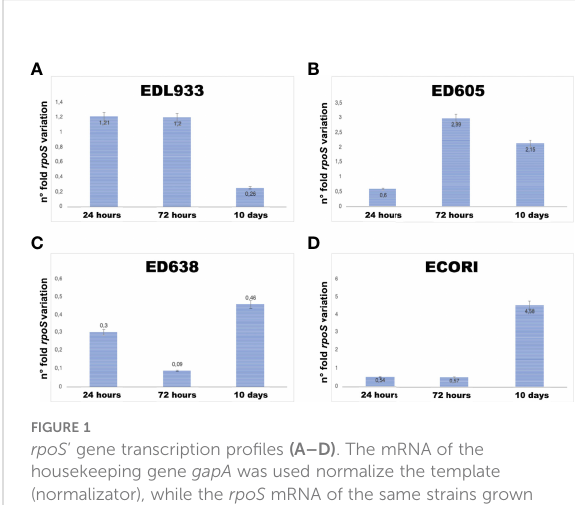
FIGURE 1 rpoS ’ gene transcription pro fi les (A – D) . The mRNA of the housekeeping gene gapA was used normalize the template (normalizator), while the rpoS mRNA of the same strains grown in broth at permissive conditions was used to calculate the relative fold change in gene expression by the 2 − DD CT threshold cycle (C T ) method (calibrator).